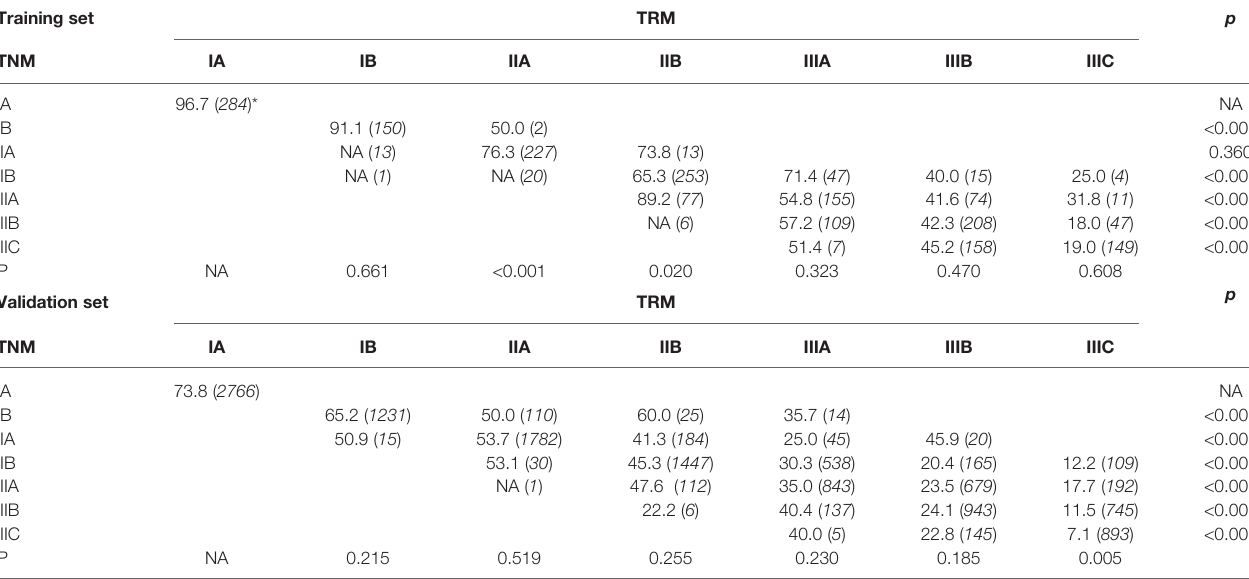
TABLE 4 | Five-Year OS by TNM Stage and TRM Stage for training set and validation set. Training set